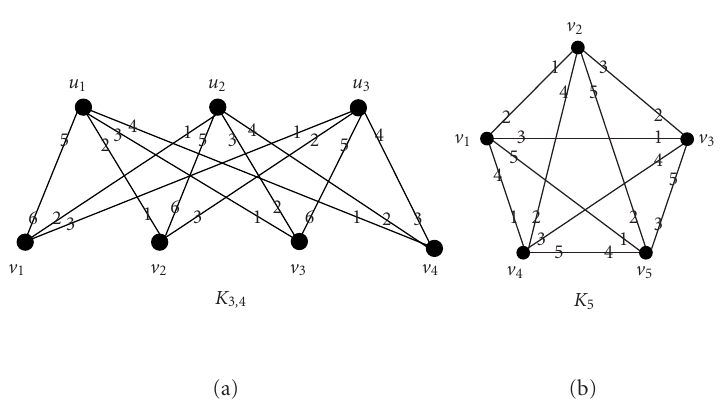
Figure 3.1. An incidence coloring of K 3,4 and K 5 ,